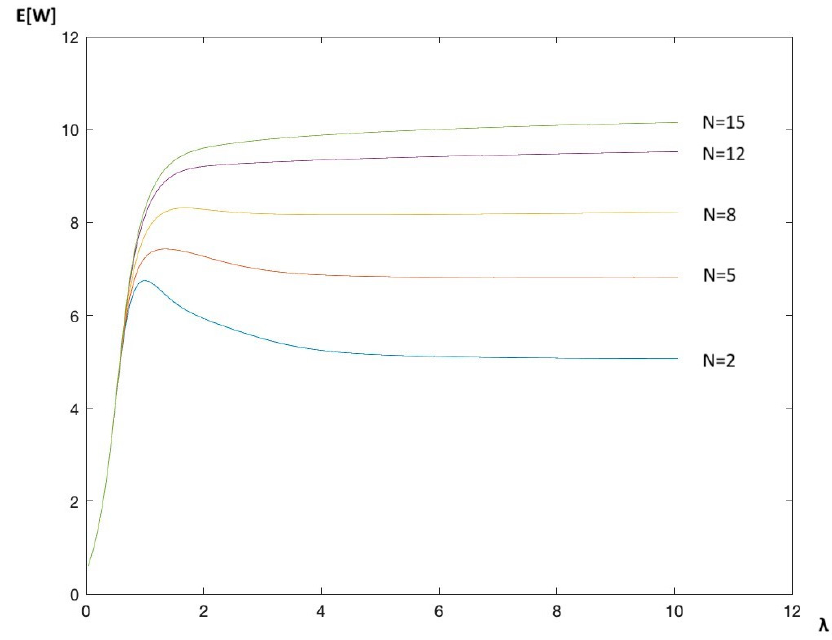
Figure 3. Mean waiting time for variable input rate of a bursty source for different values of 𝑁 .